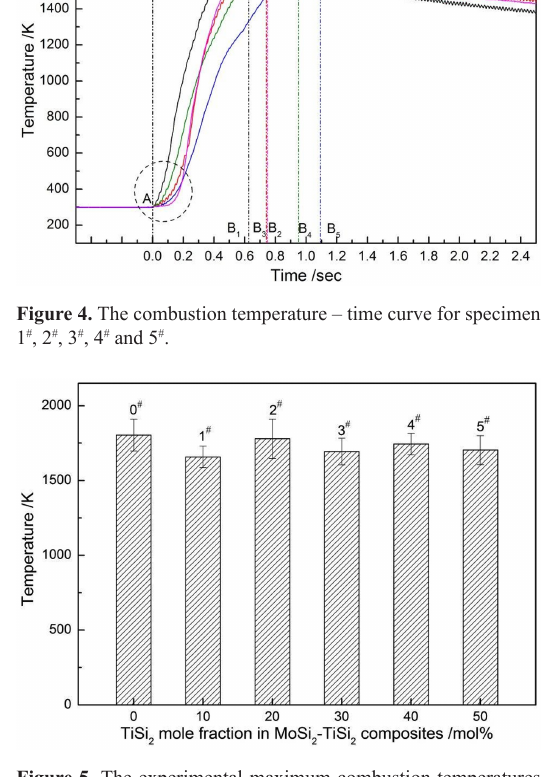
Figure 5. The experimental maximum combustion temperatures of the six different molar ratio samples.